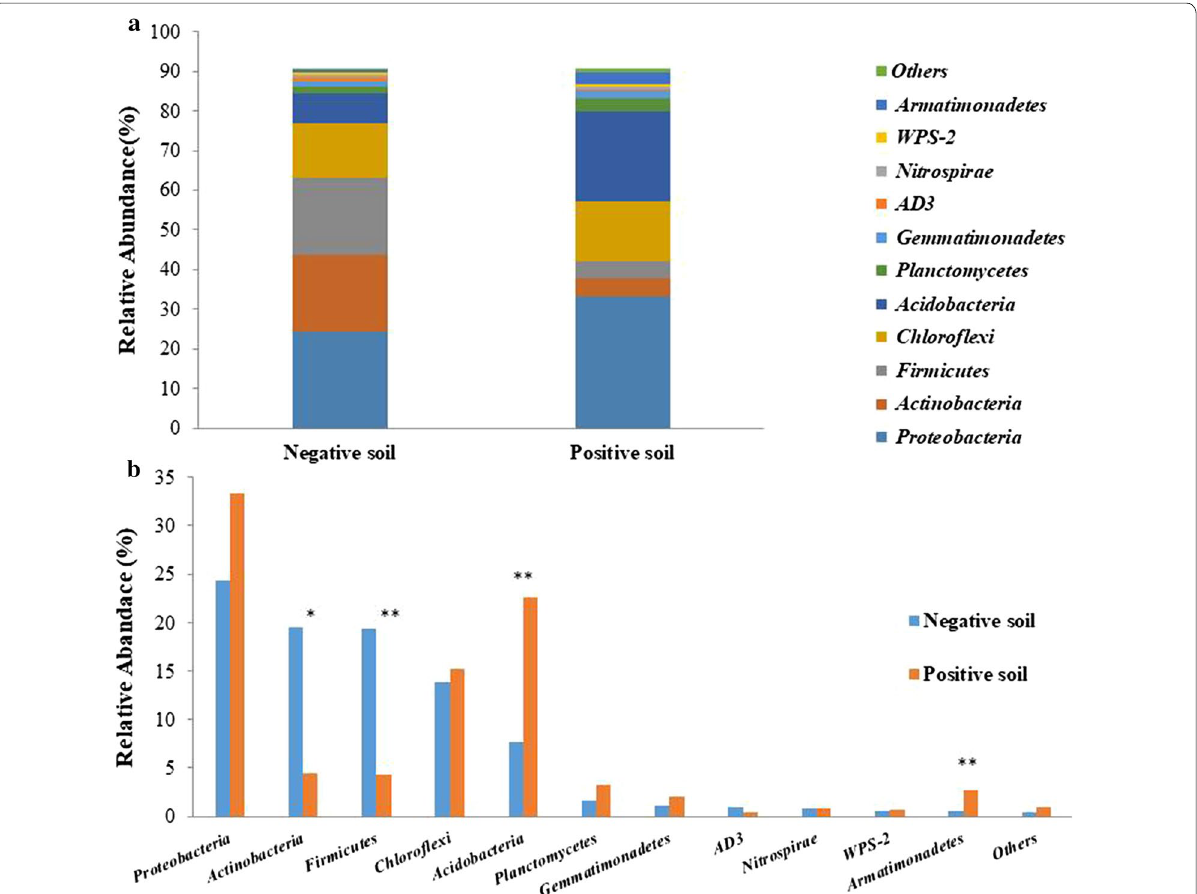
Fig. 2 The comparison of microbial composition in positive and negative soils. a The stack graph of microbes in major phyla. b The comparisons of each major phyla. The blue bars represent negative soil and orange bars represent positive soil. Asterisks (* p < 0.05, ** p < 0.001) indicate the taxa that were significantly different in relative abundances of negative and positive soil